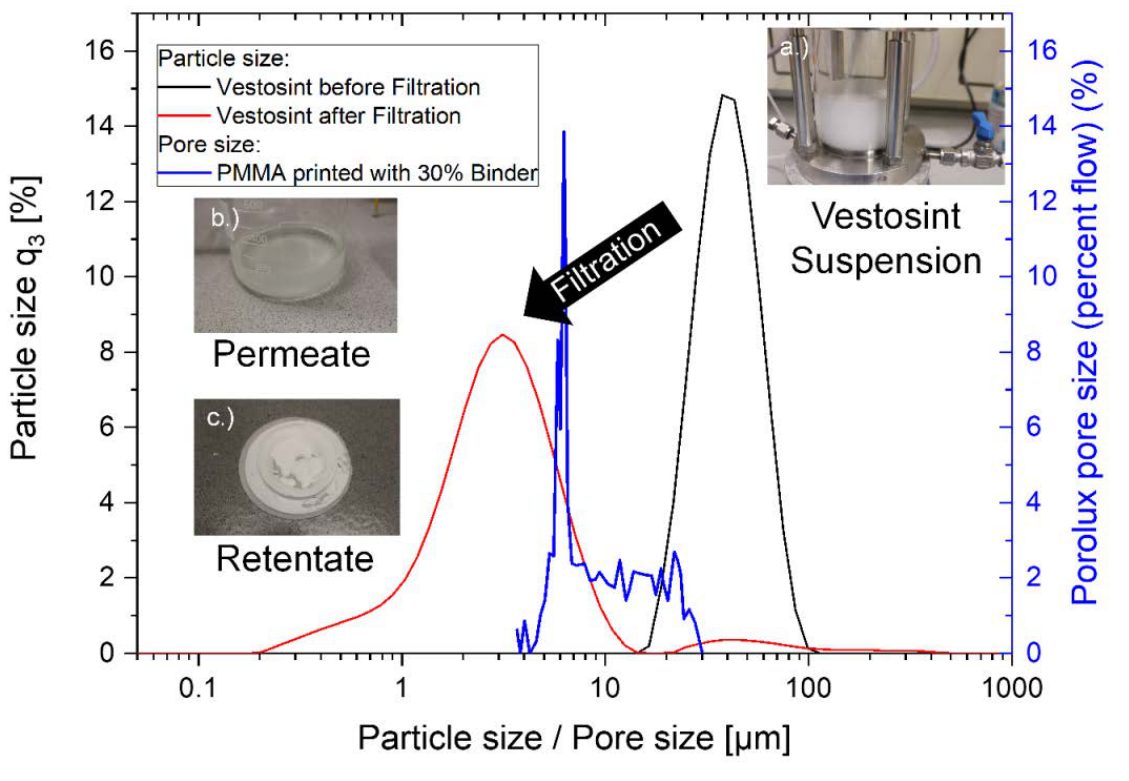
Figure 10. Pore size of printed specimen used in filtration device (blue) in comparison to the particle sizes before (black) and after (red) filtration. Inlet images: ( a ) turbid suspension (feed); ( b ) picture of permeate; ( c ) picture of filter cake on printed